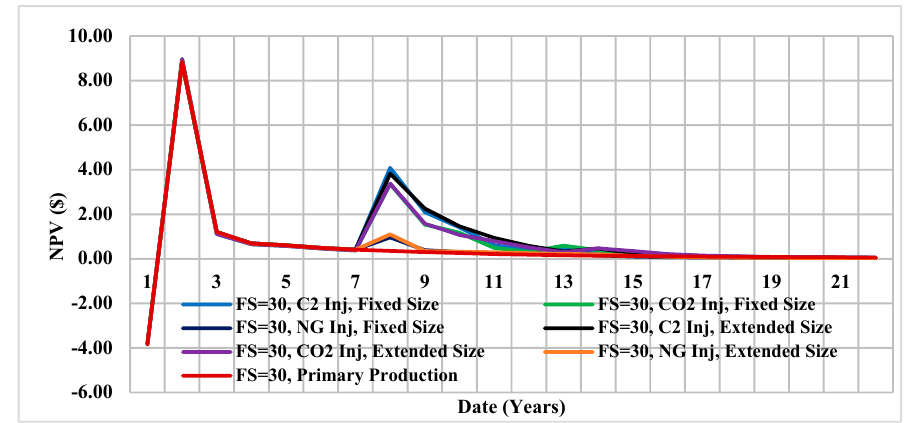
Figure 25. Cumulative NPV of the scenarios for fixed and extended cycles of cyclic CO2, C2 and NG injection as well as natural depletion, FS=10, Oil API=38.